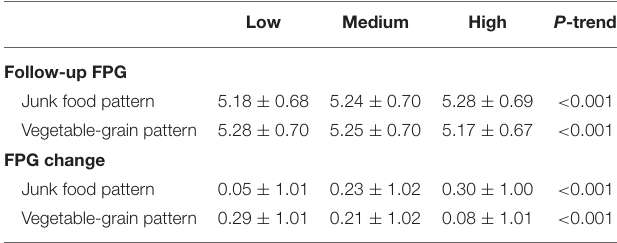
TABLE 4 | Associations between different dietary patterns, and averages of follow-up fasting plasma glucose and its changes among non-diabetic participants (mmol, Mean ±